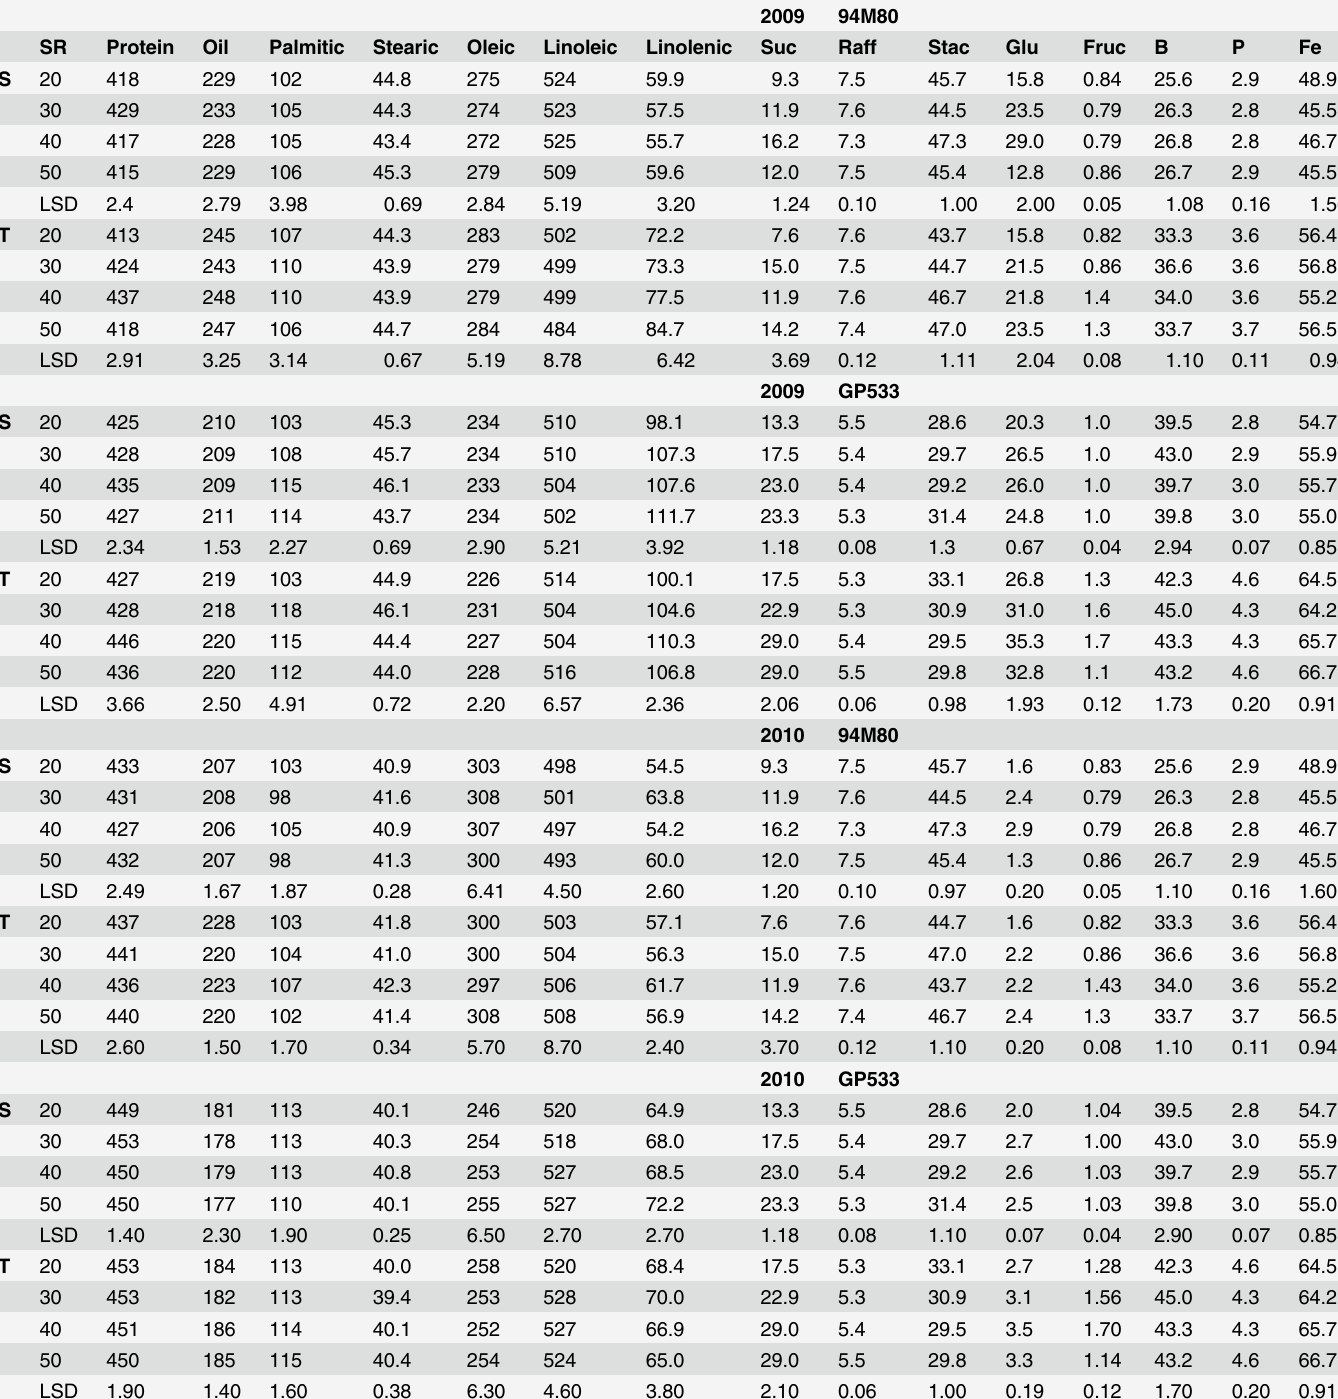
Table 5. Effects of row-type (single, S, or twin, T) and seeding rate (SR, seed m -2 ) on seed protein, oil, fatty acids (g kg -1 ), sucrose (Suc), raffinose (Raff), stachyose (Stac), glucose (Glu), fructose (Fruc) (mg g -1 ), boron (B, mg kg -1 ), phosphorus (g kg -1 ), and iron (Fe, mg kg -1 ) in two soybean culti- vars (94M80 and GP 533) in Sharkey clay